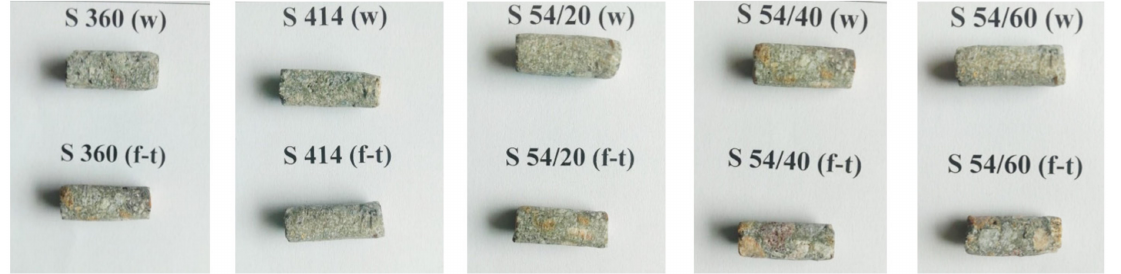
Figure 2. Samples ready for the NMR